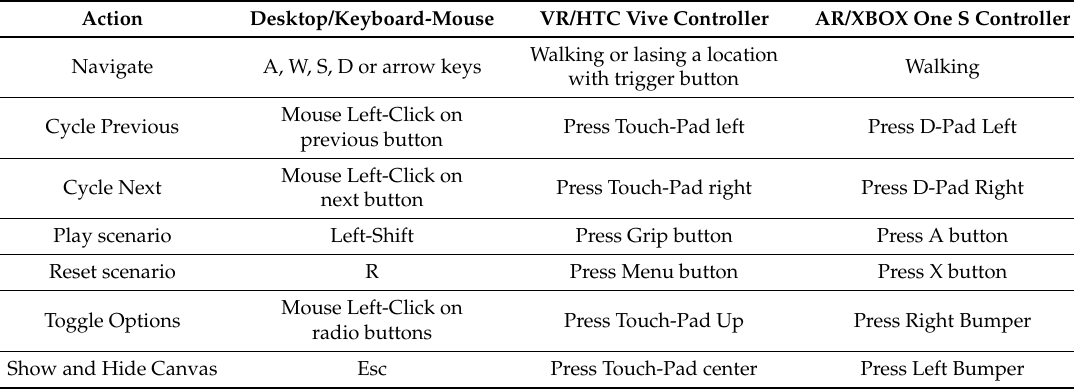
Table 1. Different input methods used to navigate through the tutoring application.